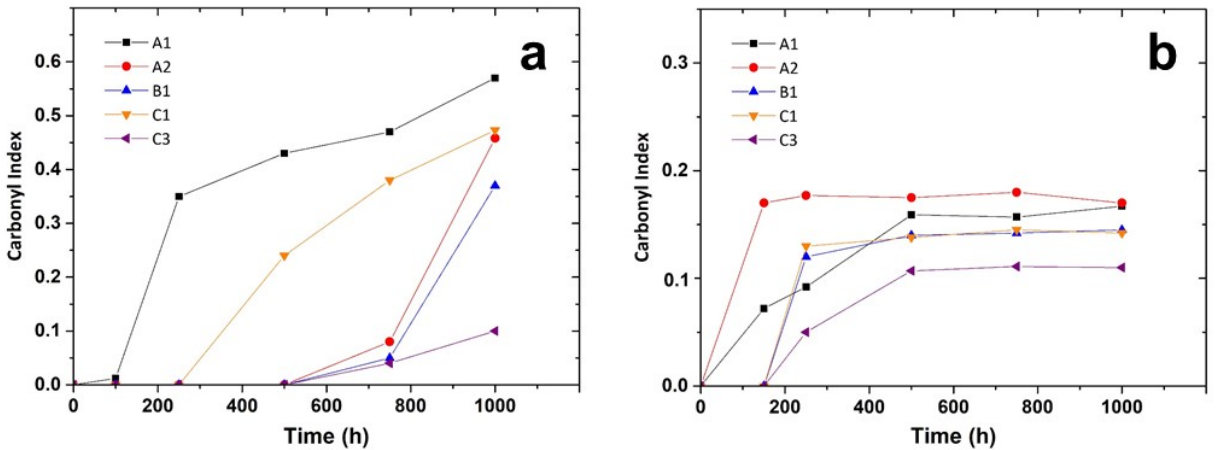
Figure 4. Carbonyl index from FTIR spectroscopy measurements of PP layers exposed to isothermal aging at 110 °C ( a ) and accelerated photoaging at 24 °C ( b ) as a function of treatment time.